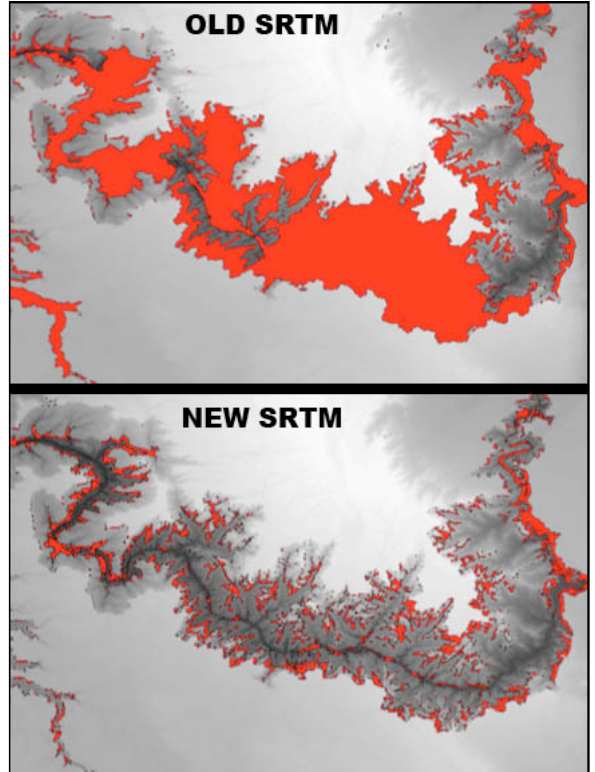
Figure 1. Voids in red, original versus reprocessed SRTM. Height as brightness, Grand Canyon, Arizona,